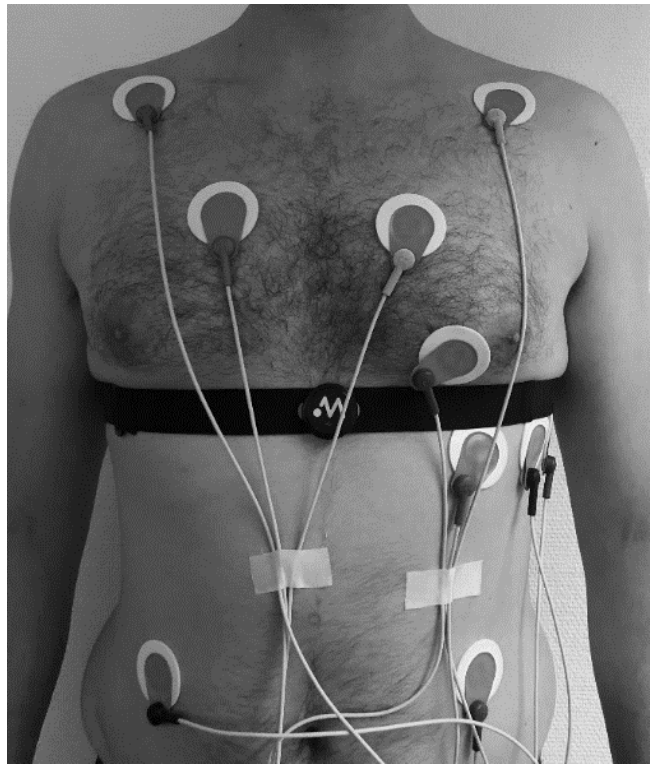
Figure 2. Placement of 12 channel ECG electrodes and Movesense Medical sensor single channel ECG with chest belt on one participant.